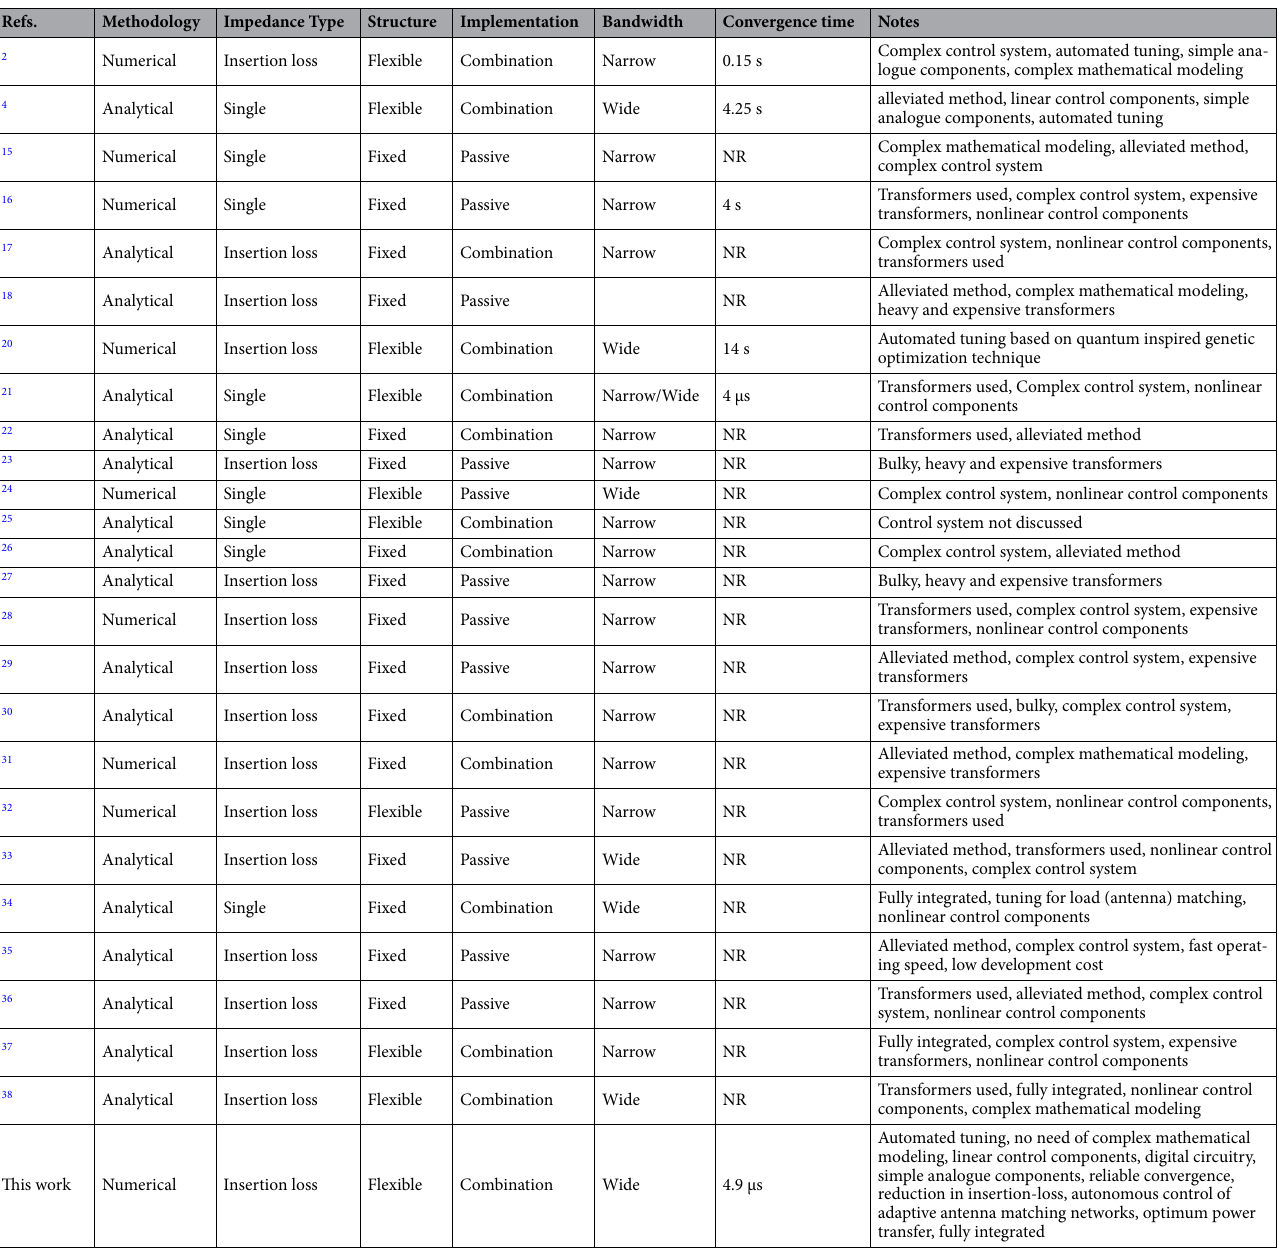
Table 2. State-of-the-art IMNS comparison. Combination: passive and active; NR: not